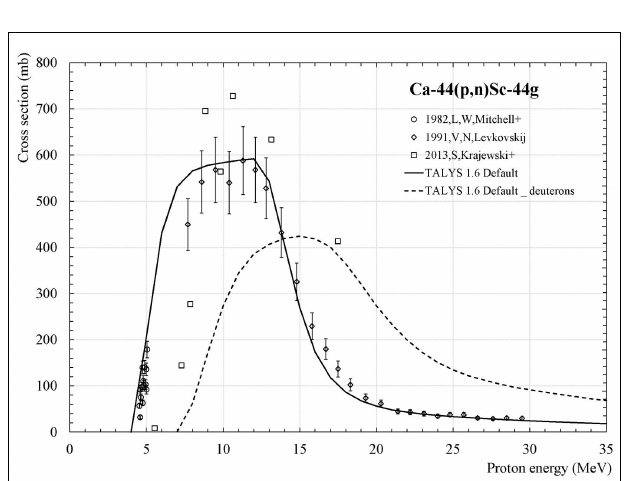
FIGURE 1 | Schematic view of the ARRONAX cyclotron and its target vaults .